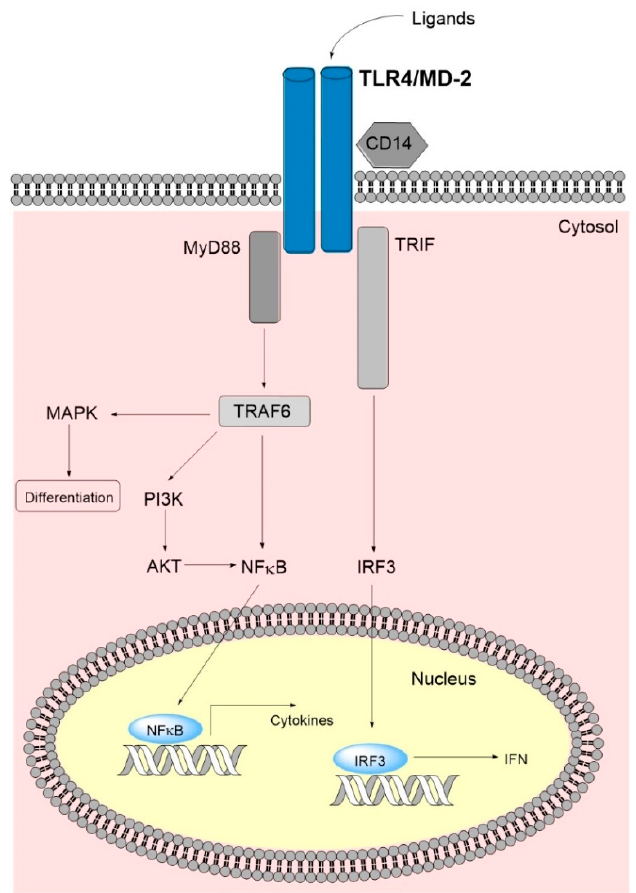
Figure 1. A simplified overview of the TLR4 main signaling pathway. Binding of ligands leads to TLR4-dimerization causing a conformational change in the C-terminal signaling domain and subsequent binding of adaptor molecules. The latter initiate signaling cascades via the MyD88 dependent and the MyD88 non-dependent/TRIF-dependent pathways. Ultimately, TLR4 signaling leads to nucleus internalization of NF κ B and IRF3 and subsequent transcription of inflammatory cytokines and type 1 IFN. The MyD88 dependent pathway interrelates, amongst others, with the MAPK and PI3K/AKT pathways, where the latter additionally signals via NF κ B, further increasing